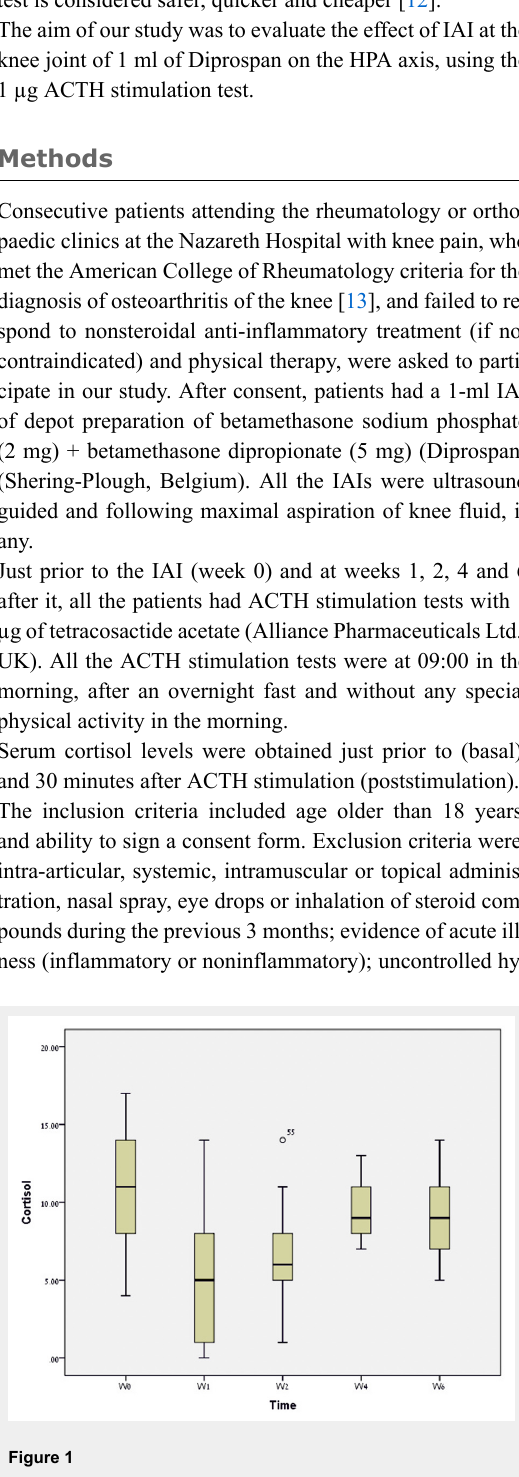
Basal serum cortisol levels at baseline and at different time points in all the patients. Box plot showing distribution of serum cortisol levels at each time- point, where the lower and upper borders of the box and the line inside it represent quartile 1 (Q1), Q3 and the median values, and the upper and lower whiskers represent Q3+ 1.5 interquartile range (IQR) and Q1-1.5 IQR, respectively. The numbered circle represents the serial number of the patient had a cortisol level higher than the upper whisker. W0 = baseline; W1 = week 1; W2 = week 2; W4 = week 4; W6